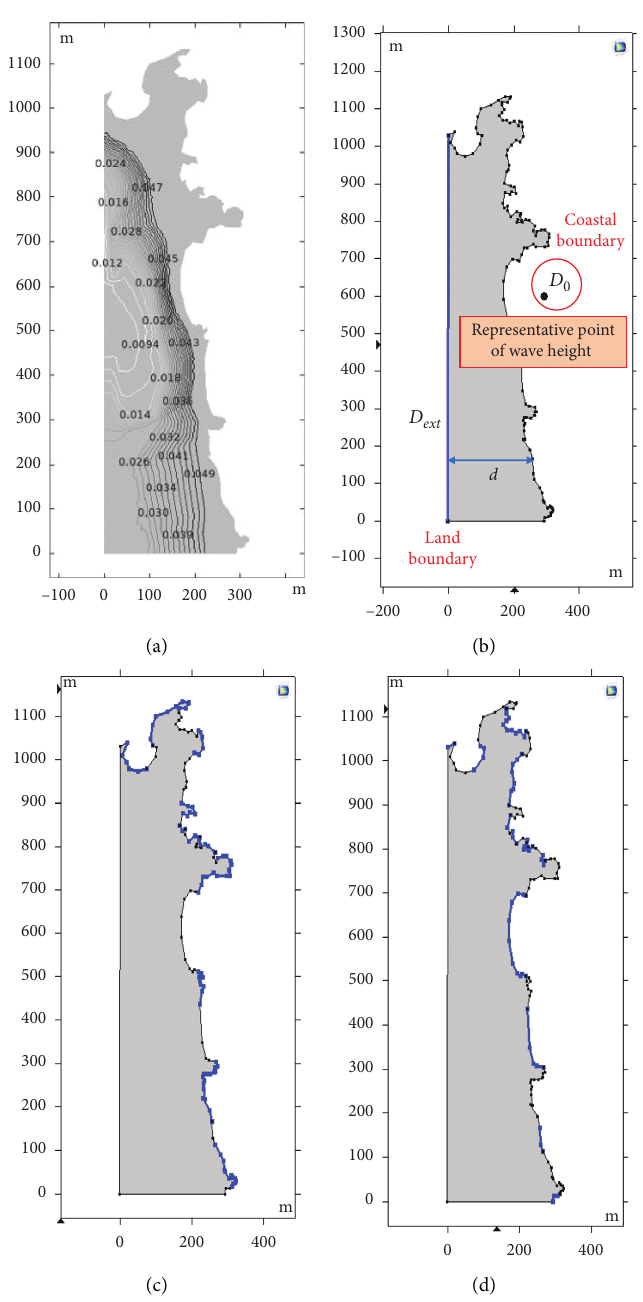
Figure 5: Coefficient and boundary conditions in the SIND model: (a) resistance coef; (b) B.C; (c) section A; (d) section